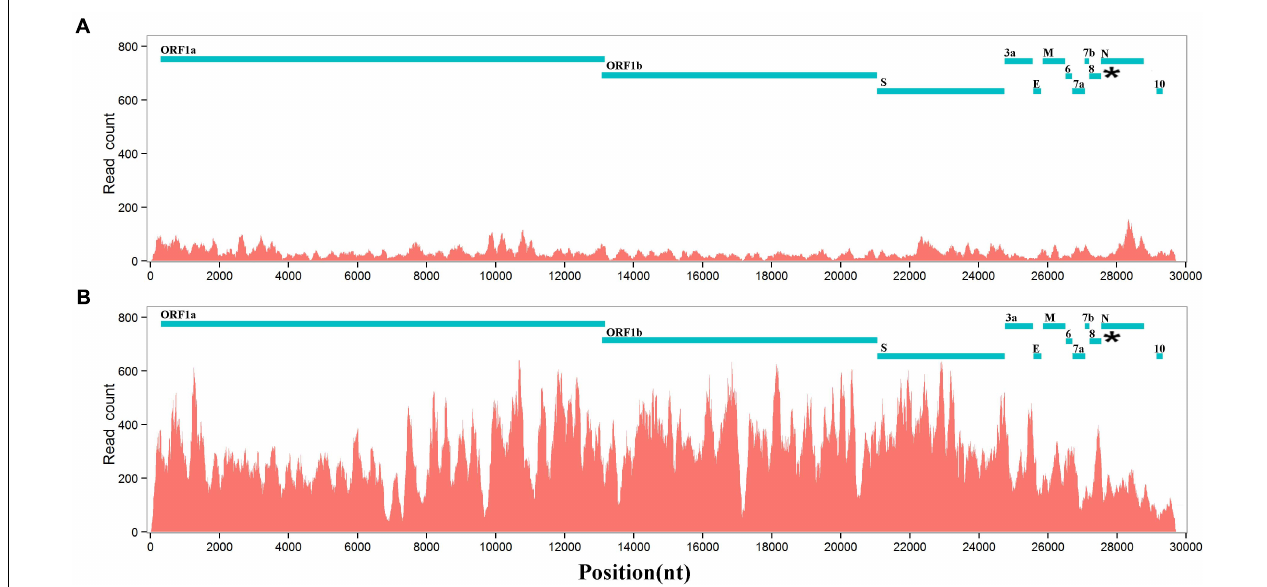
FIGURE 2 | RNA abundances of RmYN01 and RmYN02 in a bat. RNA-seq data from a bat was aligned to two genomes of RmYN01 and RmYN02 (GISAID: EPI_ISL_412976 and EPI_ISL_412977). RNA abundance is represented by read counts ( y -axis). The relative RNA abundance between RmYN02 and RmYN01 was about 9. (A) RmYN01 was identified as belonging to the SARS1 class and has a type 3 ORF8 . (B) RmYN02 was identified as belonging to the SARS2 class but has an type 2 ORF8 (enhanced ORF8